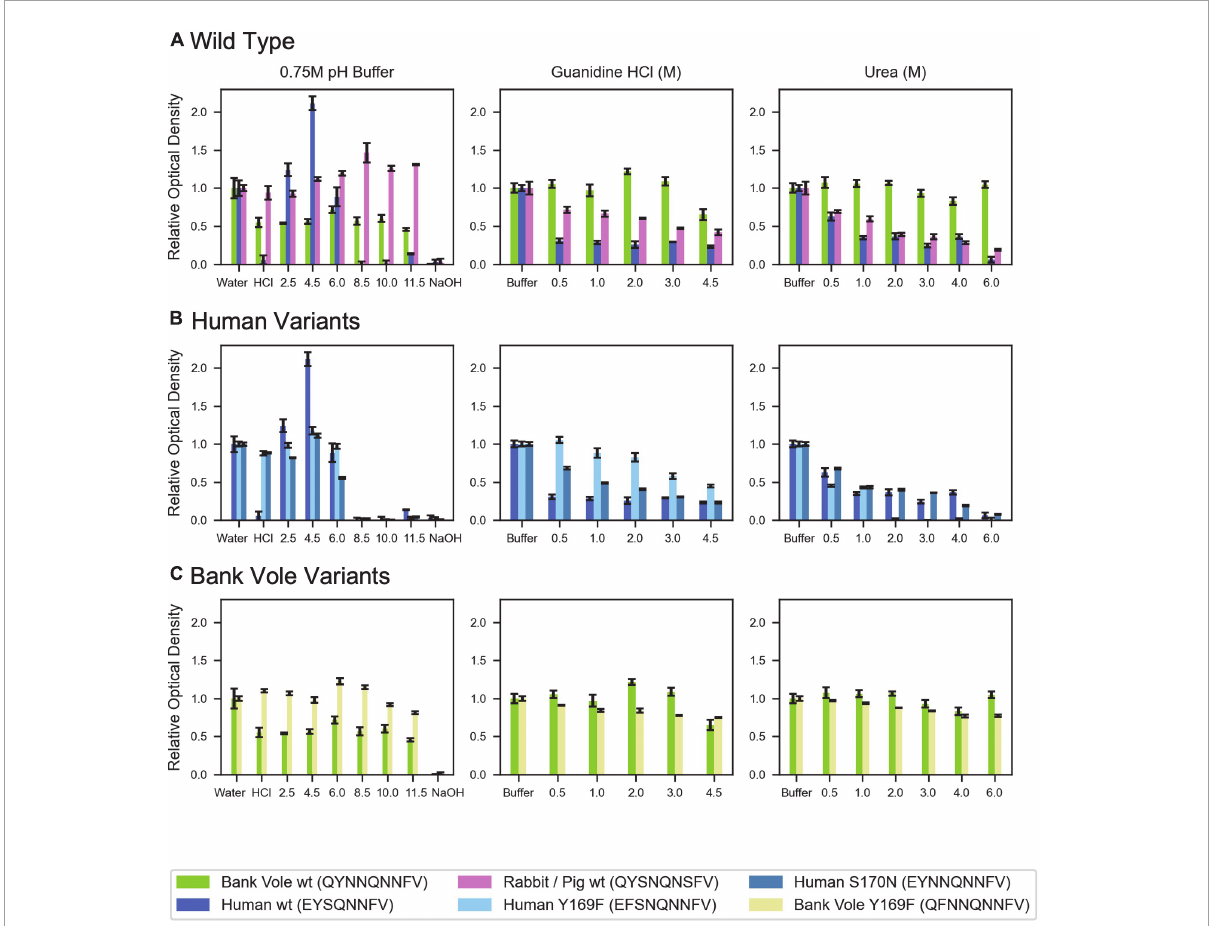
FIGURE6 Denaturation of β 2 α 2 loop crystals. (A) Wild type peptide crystals were subjected to 0.75M buffers at the specified pH (left column), increasing concentrations of guanidine HCl (center column), and increasing concentrations of urea (right column). (B) Human and (C) bank vole variants, including the wild type crystals shown in (A) , plotted on the same axis as their wild type counterparts for direct comparison. All experiments were performed in triplicate; error bars correspond to standard deviation of the